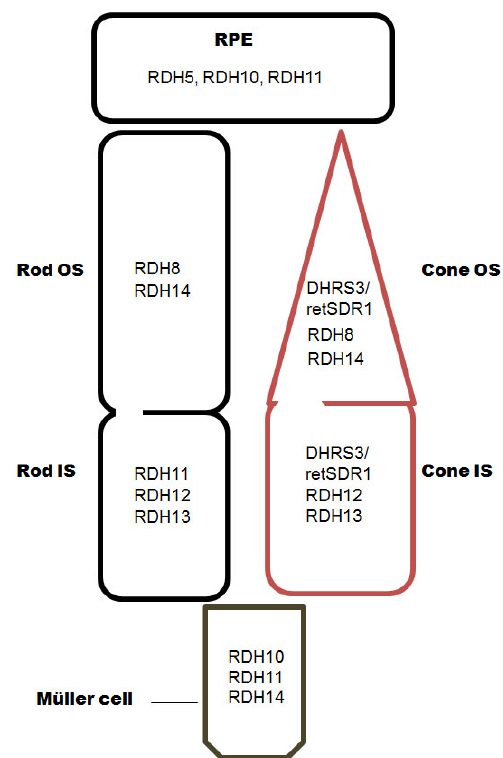
Figure 2. Localization of RDHs in the RPE and the retina. OS, outer segments; IS, inner segments.